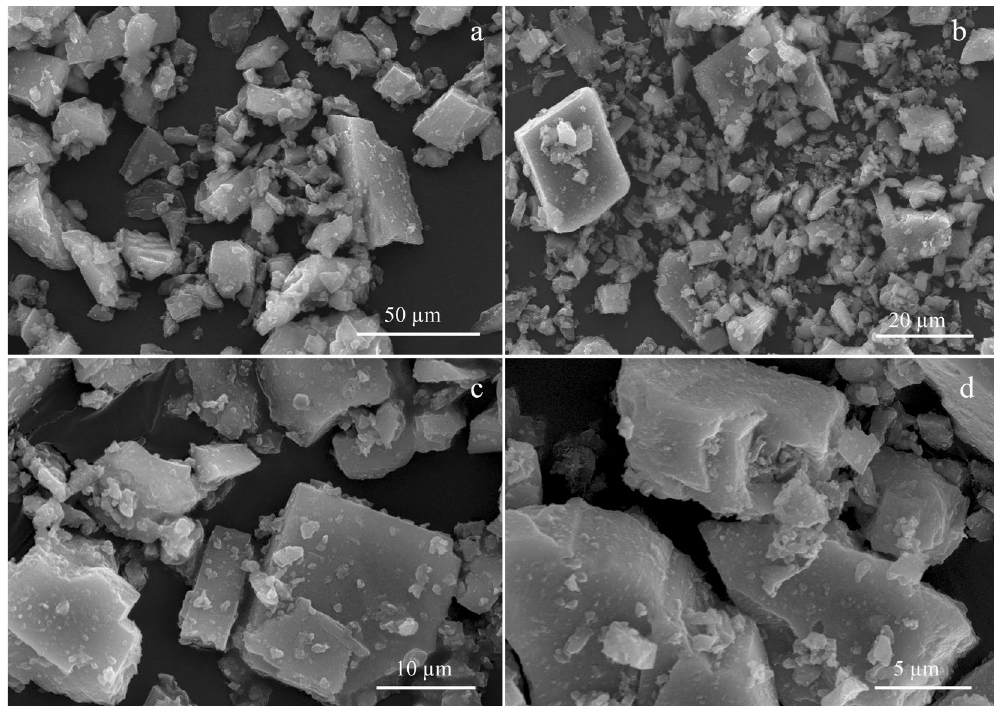
Figure 3. SEM micrographs of hydrothermal siderite particles from sterile control after the end of incubation at different ( a – d )